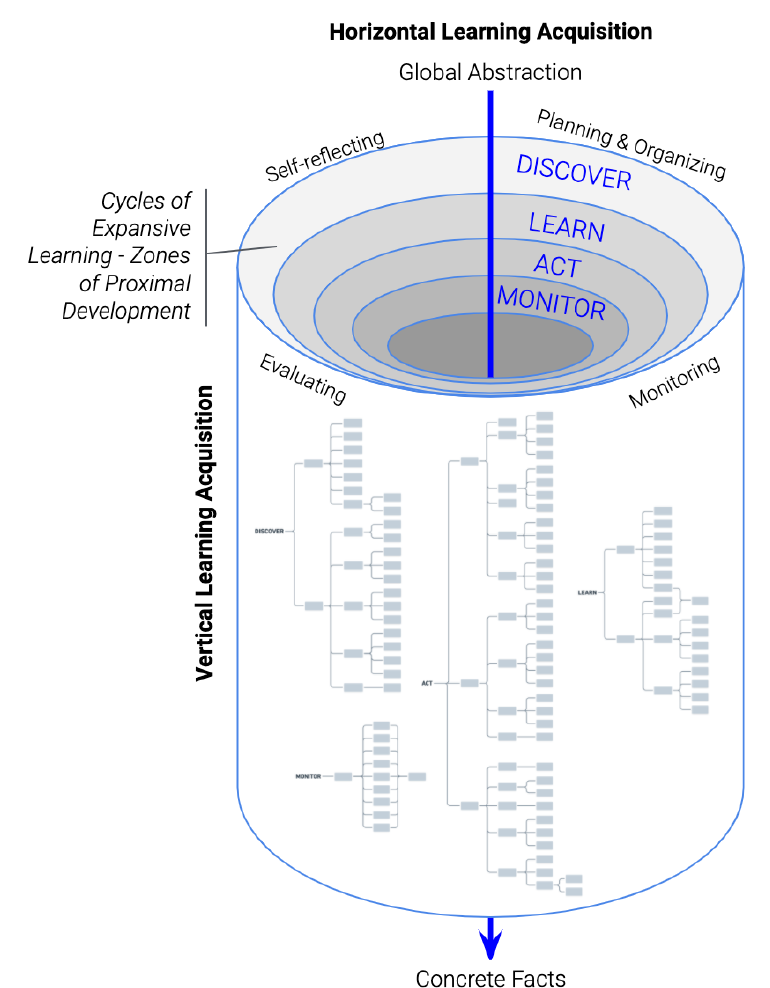
Figure 1. Engineering Usability Research Empirical Knowledge and Artifacts Taxonomy (EUREKATAX) Theoretical